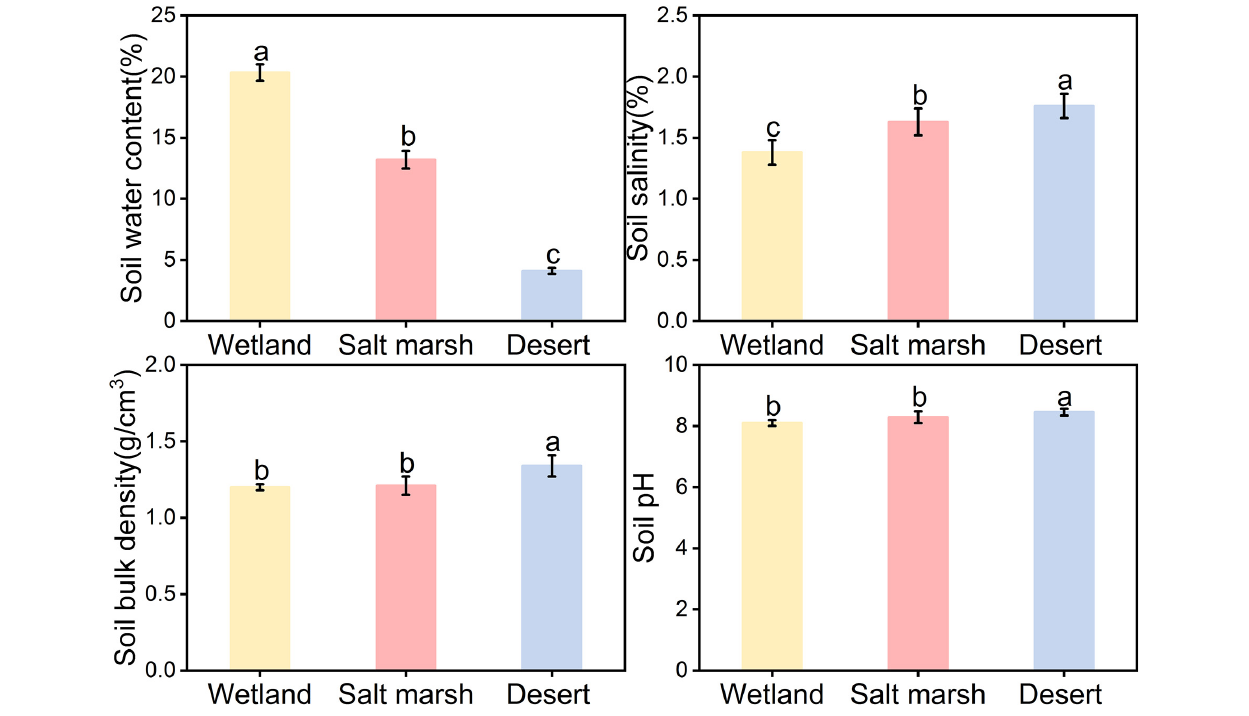
FIGURE 2 | Characteristics of soil factors under different habitats (mean ± SE, different lowercase letters indicate significant differences between habitat